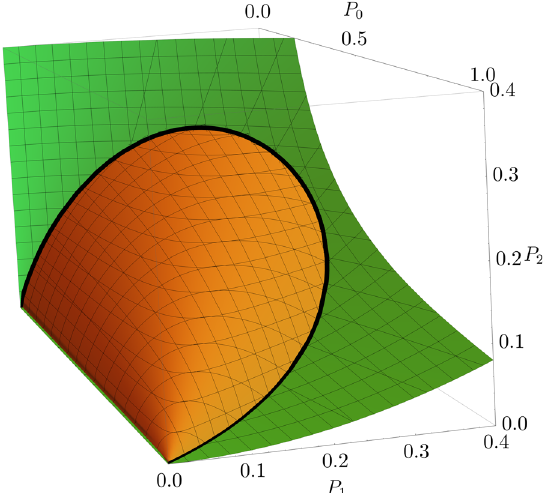
Fig. 1 Classical set in the ( P 0 , P 1 , P 2 ) space. The orange (upper) surface is the set of points on K 1 , while the green (lower) surface the set of points on K 1 . The black line is the set of coherent states. We notice that the upper surface can be generated as the set of lines going from (1, 0, 0) to the coherent states, while the lower surface as the set of lines going from (0, 0, 0) to the coherent states. All the states with probabilities lying above the upper surface will satisfy Klyshko ’ s inequalities, and can therefore be detected as nonclassical only using Eq. (13).